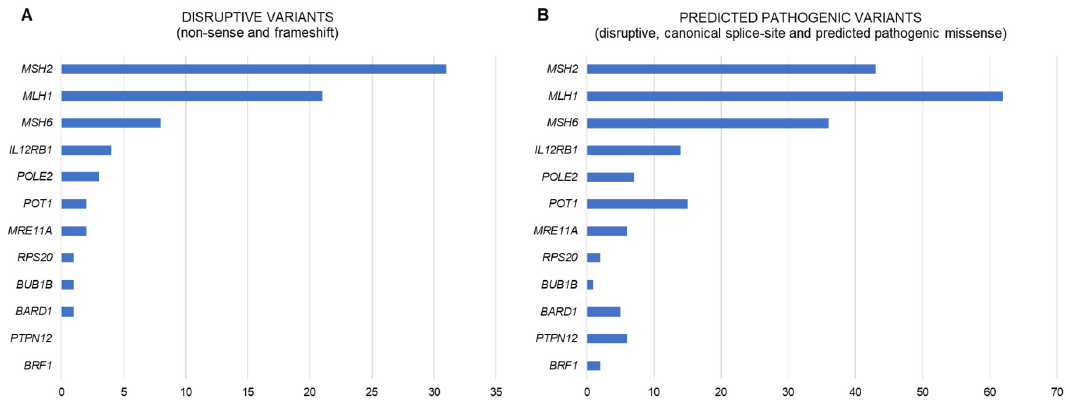
Figure 2. ( A ) Number of disruptive (non-sense and frameshift) and ( B ) predicted pathogenic (disruptive, canonical splice-site, and predicted pathogenic missense) variants identified in the MMR genes MLH1 , MSH2 and MSH6 , RPS20 , and in the most promising candidate genes for nonpolyposis CRC predisposition, in 1006 familial / early onset CRC cases. PMS2 was not included in the graph due to the possibility of miscalled variants due to the existence of multiple pseudogenes. Data obtained from Chubb et al., 2016 [28].